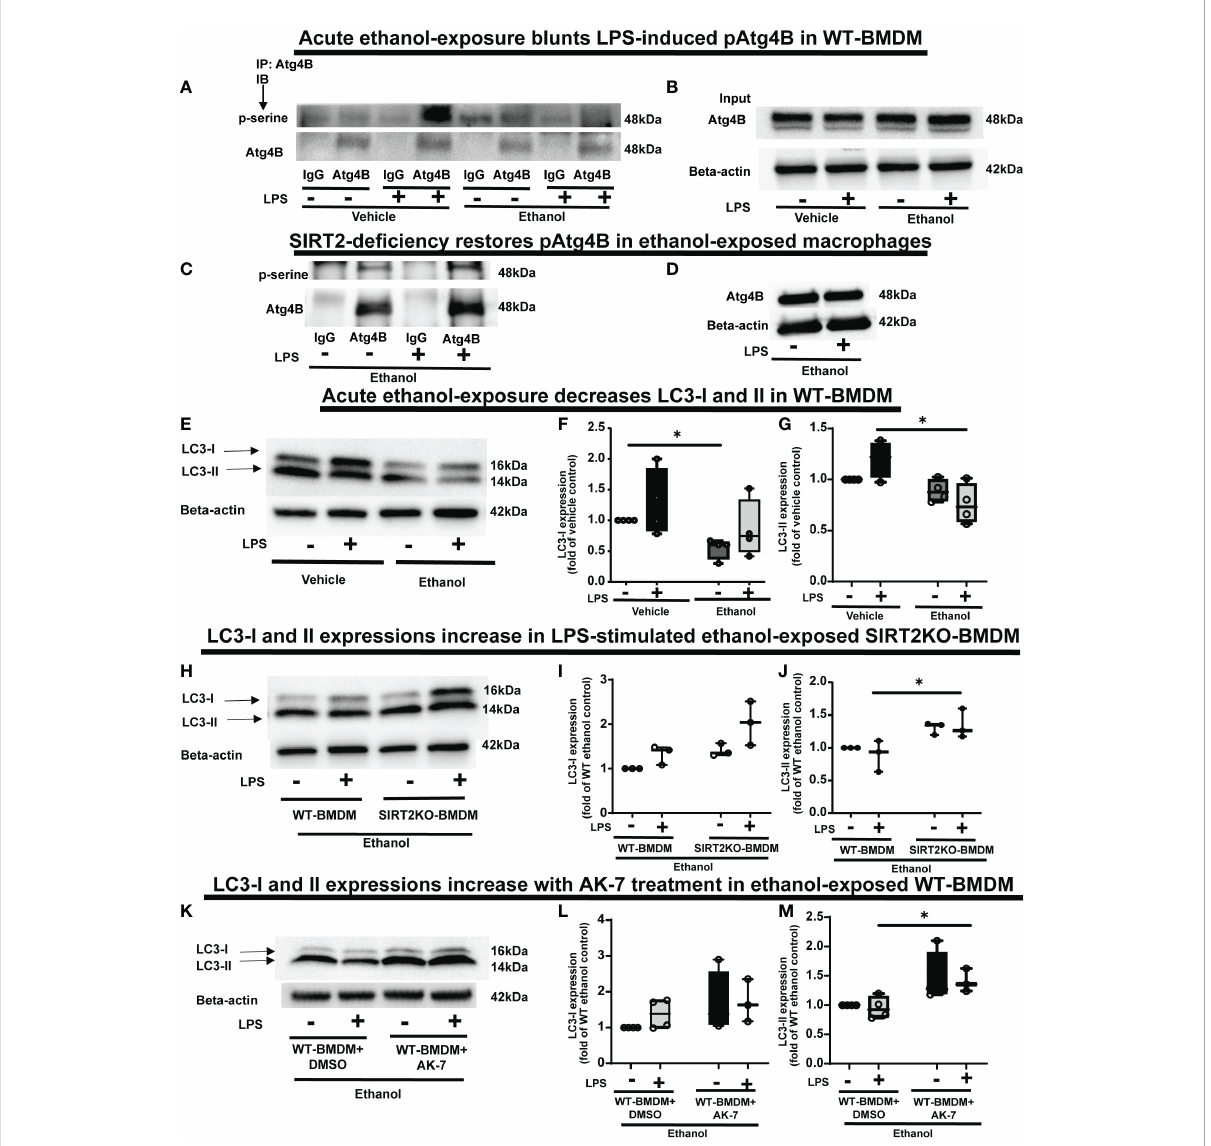
FIGURE 7 The effect of acute ethanol-exposure on pAtg4B and microtubule associated protein 1 light chain-3B (LC3) I and II expression in macrophages. (A) WT-BMDM were exposed to vehicle or ethanol ± LPS. Atg4B was immunoprecipitated (IP) from whole-cell lysates of WT-BMDM using an anti-Atg4B antibody followed by IB analysis of pSerine and total Atg4B. IP with IgG control antibody was used as a negative control. (B) Western blot analysis of total Atg4B in the whole cell lysate used as input for the Atg4B IP. (C) SIRT2KO-BMDM were exposed to ethanol ± LPS. IP for Atg4B from whole-cell lysates of SIRT2KO-BMDM using an anti-Atg4B antibody followed by IB analysis of pSerine and total Atg4B. IP with IgG control antibody was used as a negative control. (D) Western blot analysis of total Atg4B in the whole cell lysate used as input for the Atg4B IP. (E) LC3-I and LC3-II expression were analyzed by western blot in WT-BMDM exposed to vehicle or ethanol ± LPS. Western blot image quanti fi cation of ethanol vs. vehicle-expose WT-BMDM± LPS, showing LC3-I in (F) and LC3-II in (G) , normalized to vehicle control (Vehicle-LPS) (n = 4 blots; * p < 0.05). (H) Western blot analysis of LC3-I and II expression in Ethanol-exposed WT-BMDM and SIRT2KO-BMDM ± LPS. Western blot image quanti fi cation in Ethanol-exposed WT-BMDM and SIRT2KO-BMDM ± LPS for LC3-I in (I) and LC3-II in (J) , normalized to ethanol control (Ethanol-LPS) (n = 4 blots; * p < 0.05). (K) . Western blot analysis of LC3-I and II expression of Ethanol-exposed WT-BMDM treated with AK-7 or DMSO ± LPS. Western blot image quanti fi cation of Ethanol-exposed WT-BMDM treated with AK-7 or DMSO ± LPS for LC3-I in (L) and LC3-II in (M) normalized to ethanol control (Ethanol-LPS) (n = 3 blots; * p <